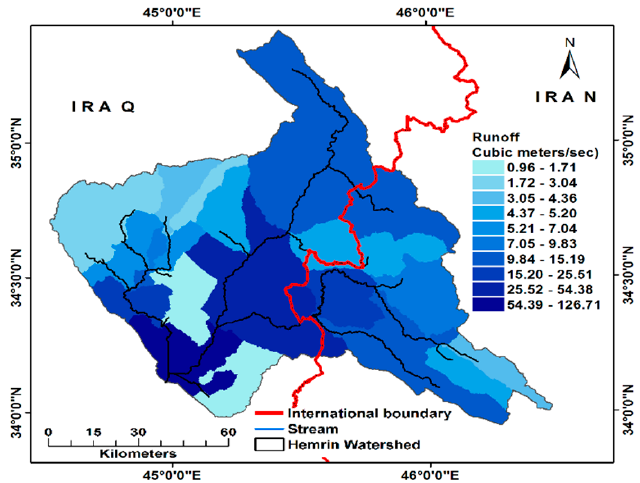
Figure 18. Average streamflow for the Hemrin Watershed at the sub-basin level for the period from 1984 to 2013.